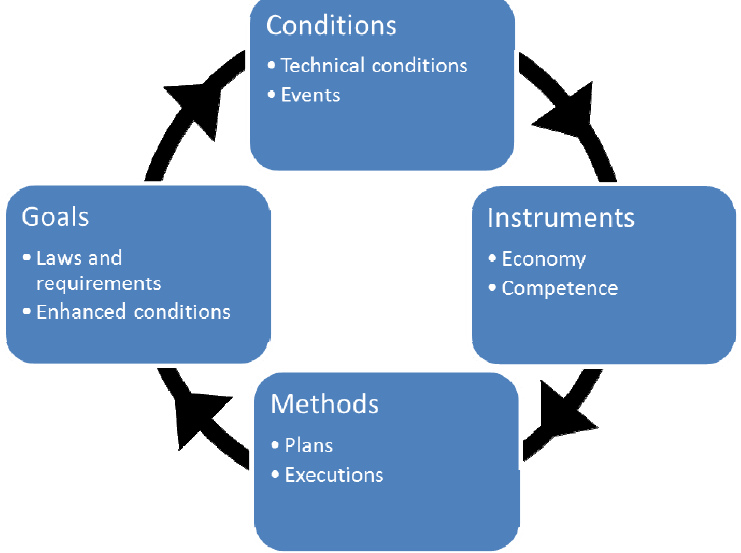
Figure 2. Factors affecting flood and SuDS–focus—illustrated as a continuous